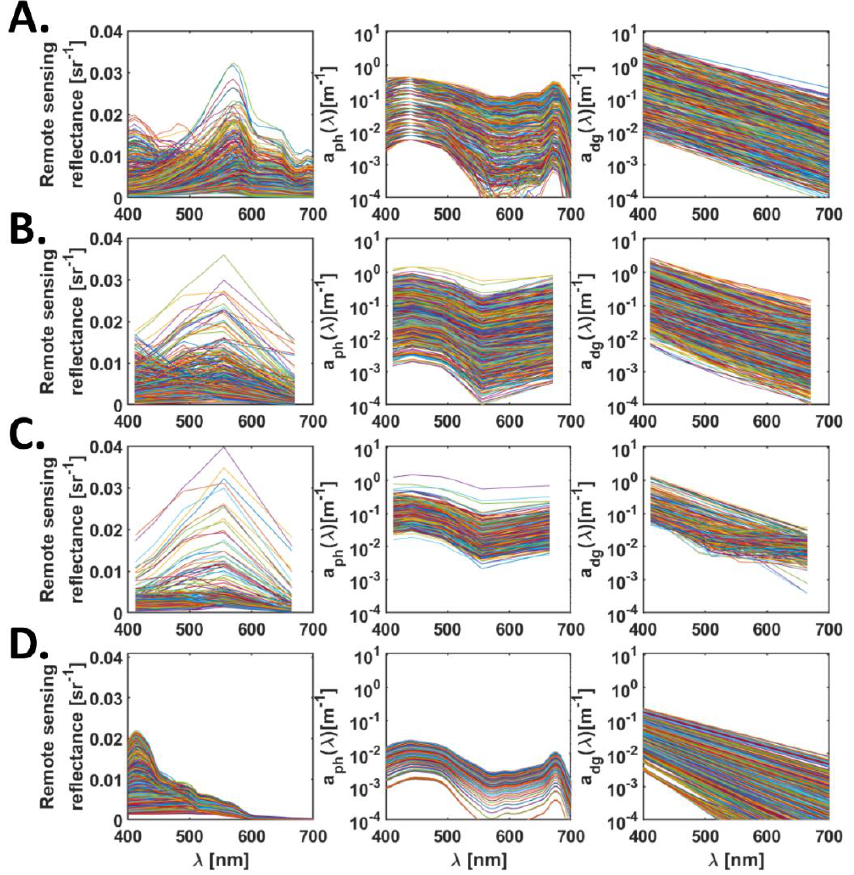
Figure 2. Variation in remote sensing reflectance, absorption due to phytoplankton a ph ( λ ) and absorption due to coloured detrital matter a dg ( λ ) observed in ( A ) IOCCG, ( B ) GB, ( C ) CCRR and ( D ) the Red Sea datasets.